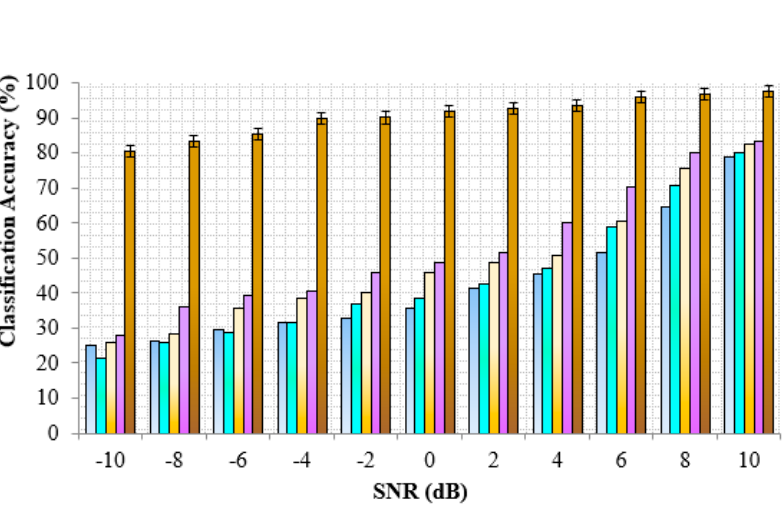
Figure 10. Comparison of classification accuracy (Scenario 1).